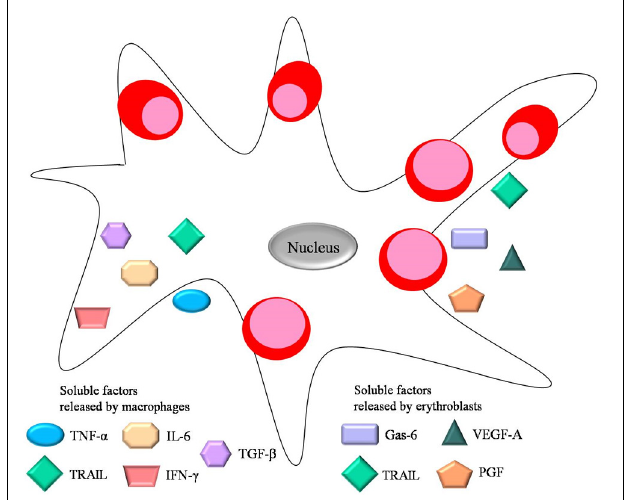
FIGURE 3 | Soluble factors important for erythropoiesis. Both central macrophage and erythroblast secrete soluble factors during erythropiesis. These include the negative regulators TNF- α , TGF- β , IL-6, IFN- γ released by the central macrophage, and the positive regulators Gas-6, VEGF-A and PGF released by erythroblasts. TRAIL is a negative regulator secreted by both erythroid cells and